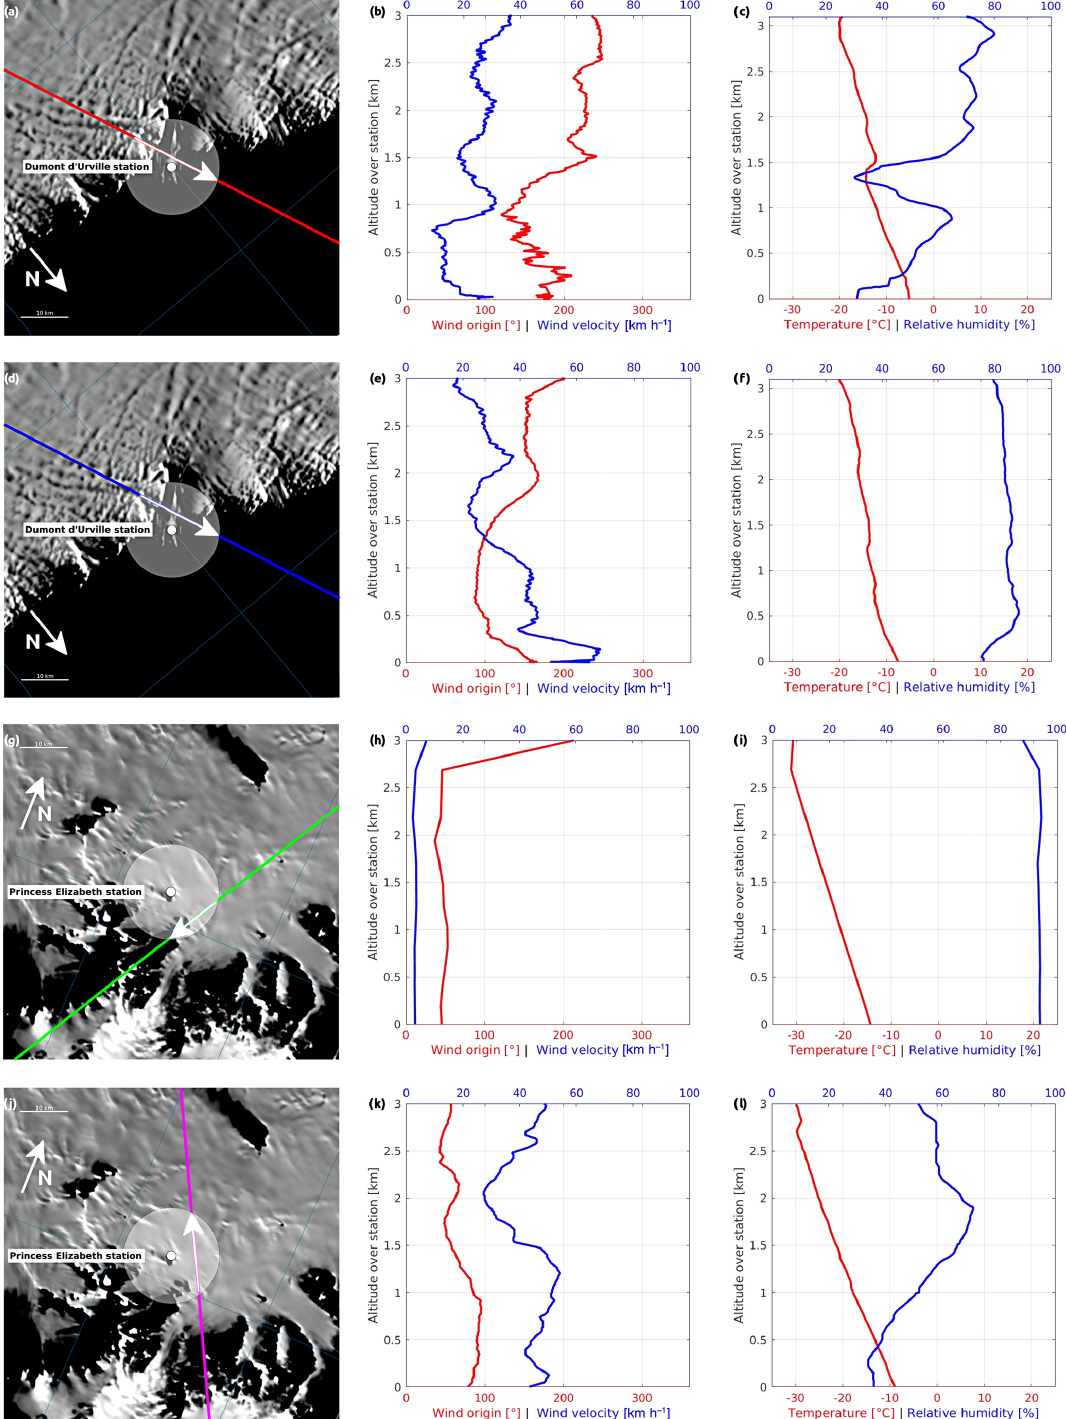
Figure 2. Vertical profiles of the lower-tropospheric meteorological parameters over DDU and PE stations for the four precipitation events. The radiosonde launch times are summarized in Table 1. (a, d, g, j) The first column shows each station location, selected CloudSat tracks and their directions. The white disk represents a 10km radius area around each station in which we consider the CloudSat measurements. (a–c) 17 February 2016; (d–f) 20 March 2016; (g–i) 15 February 2011; (j–l) 13 January 2015. The background image is the hill-shaded topography obtained with MODIS MOA2004 (Haran et al., 2005). (b, e, h, k) The second column shows wind velocities (blue solid line) and wind directions (0 ◦ indicating from the north) (red solid line) over the stations gathered with radiosoundings, except for panel (h) , which is obtained with ERA-Interim. (c, f, i, l) The third column shows air temperatures (red solid line) and relative humidities with respect to ice (blue solid line) over the stations obtained with radiosoundings, except for panel (i) , which is deduced from ERA-Interim. The Cryosphere, 13, 943–954, 2019